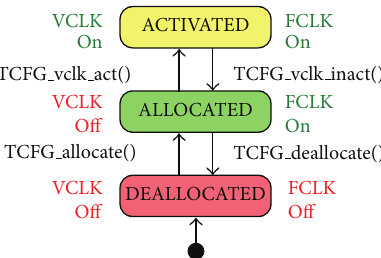
Figure7:RRState(HWTSchedulingandPlacementLayerperspec-